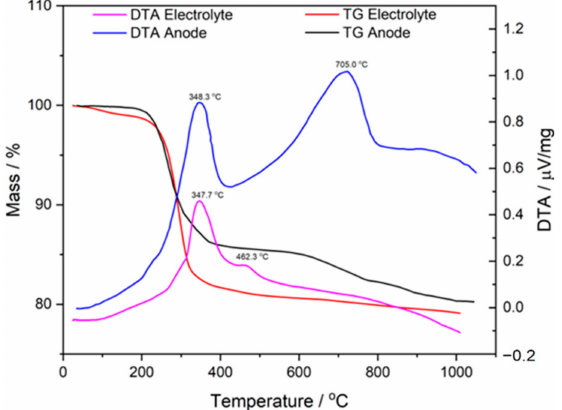
Figure 4. Comparative analysis of differential thermal analysis (DTA)/thermogravimetry (TG) for 5CBCY electrolyte and NiO–5CBCY anode